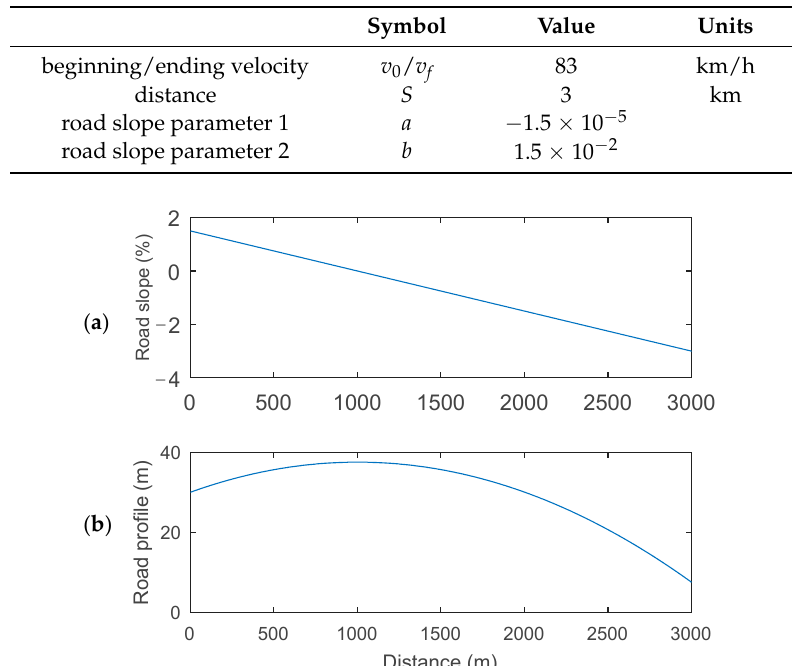
Table 2. Parameters for the convex road profile situation.